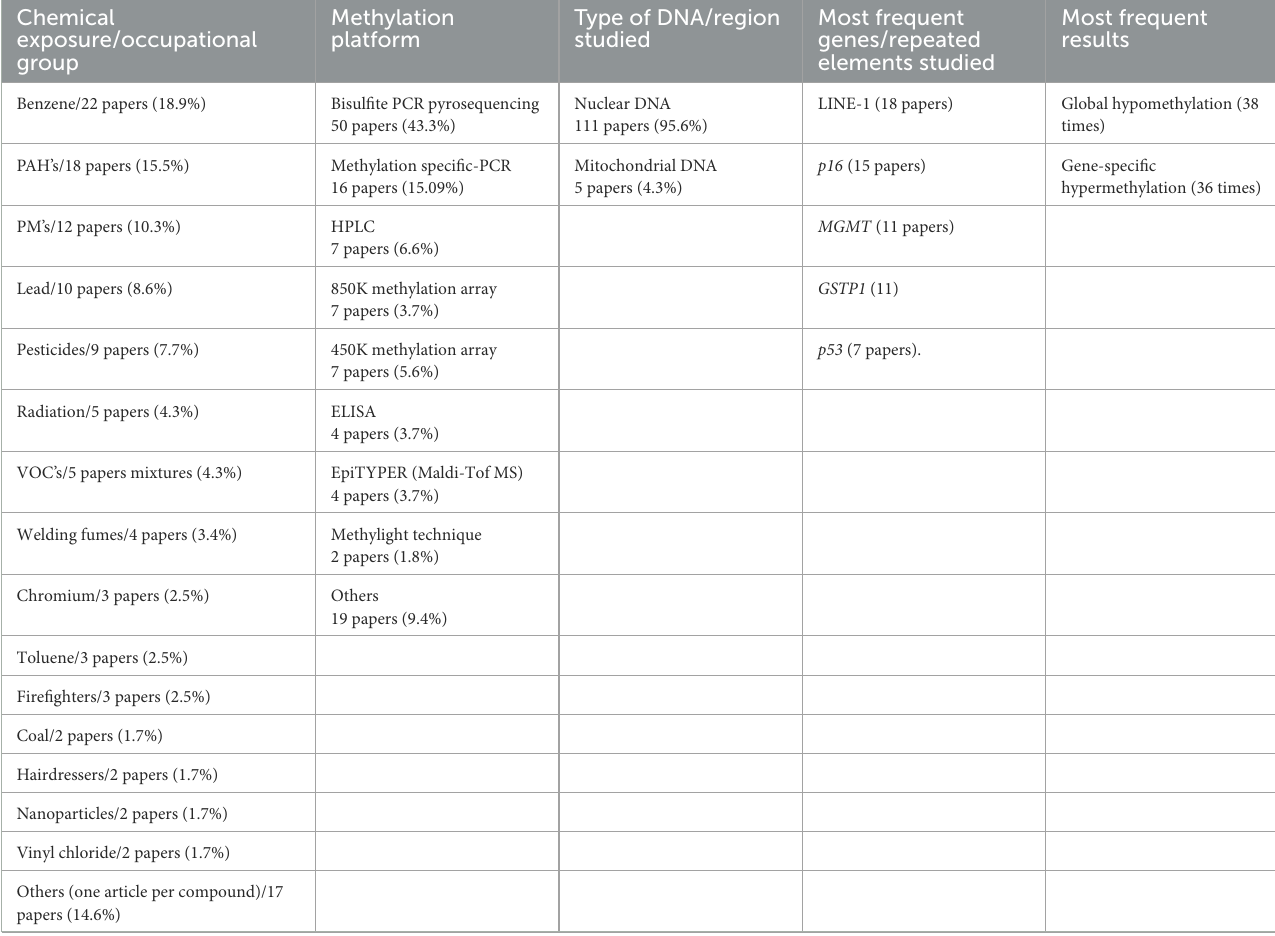
TABLE 1 General characteristics of the research papers selected in the review. Chemical